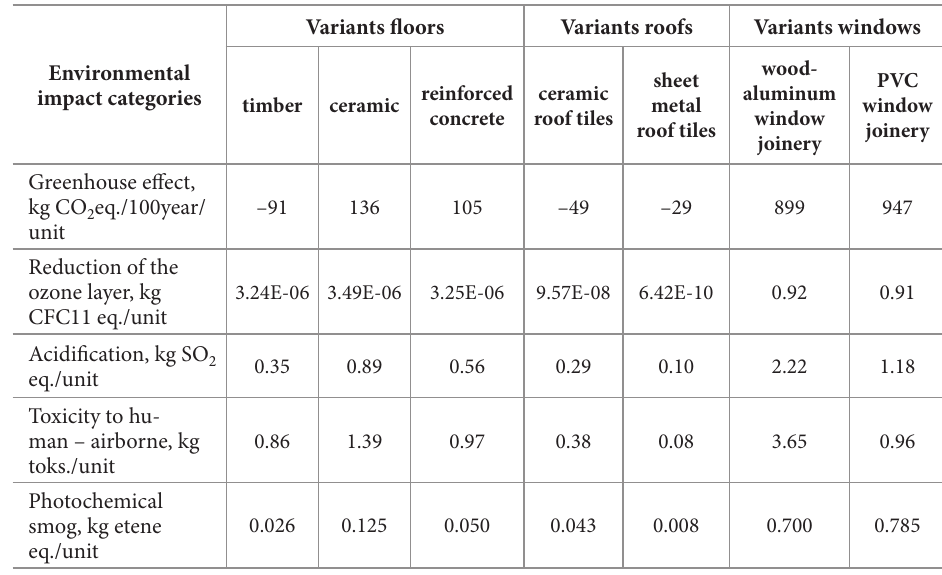
Table 3. Values of environmental impact vectors in the whole life cycle of a floor, roof and windows per 1m 2